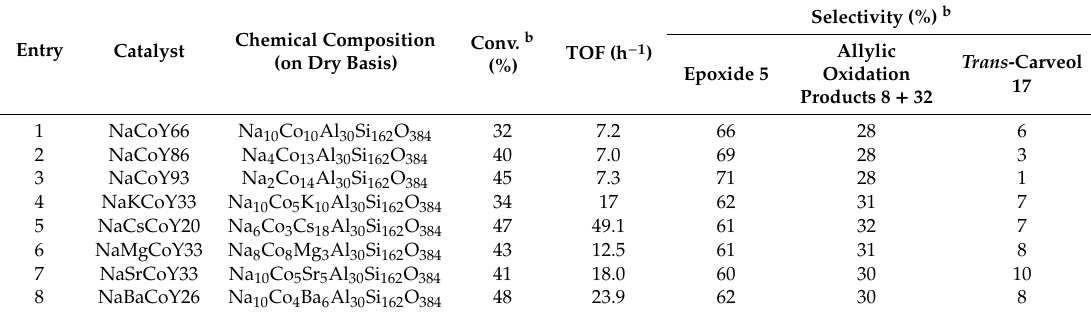
Table 9. Oxidation of limonene with titanium-MCM-41 catalysts a (adapted from reference [42]).